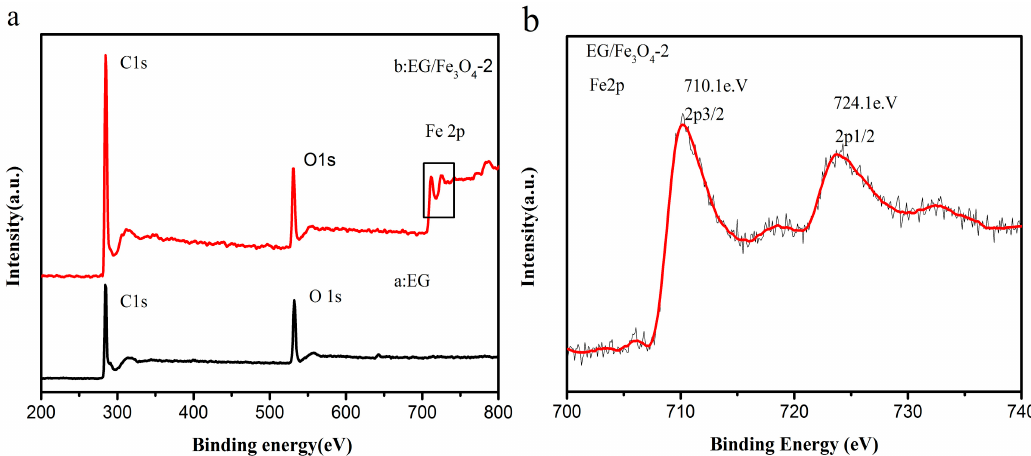
Figure 6. X-ray photoelectron spectroscopy (XPS): ( a ) wide scan, ( b ) Fe 2p spectrum of the EG/Fe 3 O 4 composite.